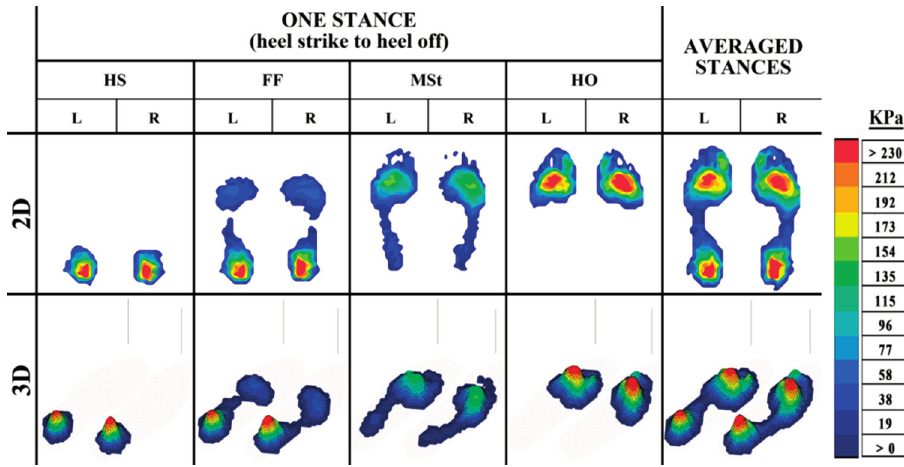
Figure 3. The 2D and 3D representation of in-shoe plantar pressure distribution in a healthy control during the stance phase of the gait cycle, from HS to HO, and the averaged pressure distribution from four stances.